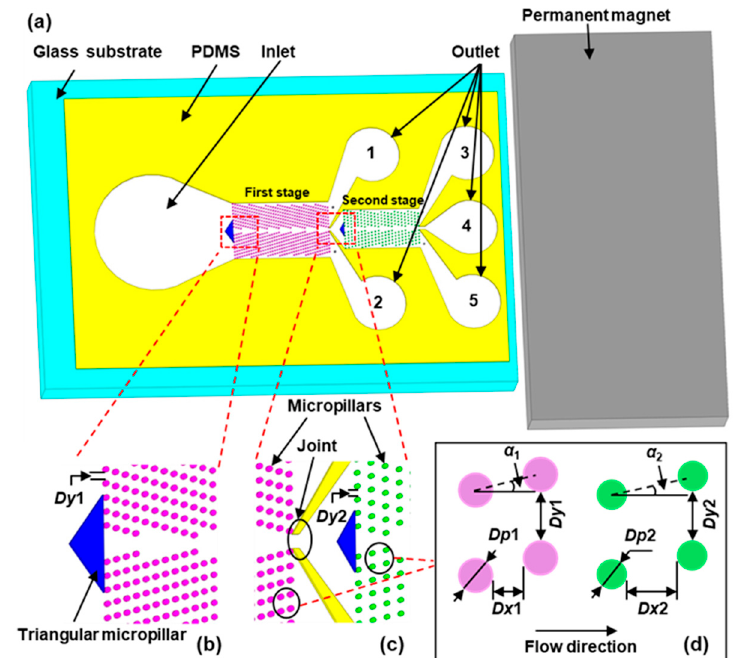
Figure 1. Schematic illustrations of ( a ) the magnetic-driven deterministic lateral displacement (m-DLD) chip, ( b ) the inlet and the first stage of micropillar arrays, ( c ) the junction of the first stage and the second stage and ( d ) parameters of the first and second stages of mirrored cylindrical arrays in the DLD design.